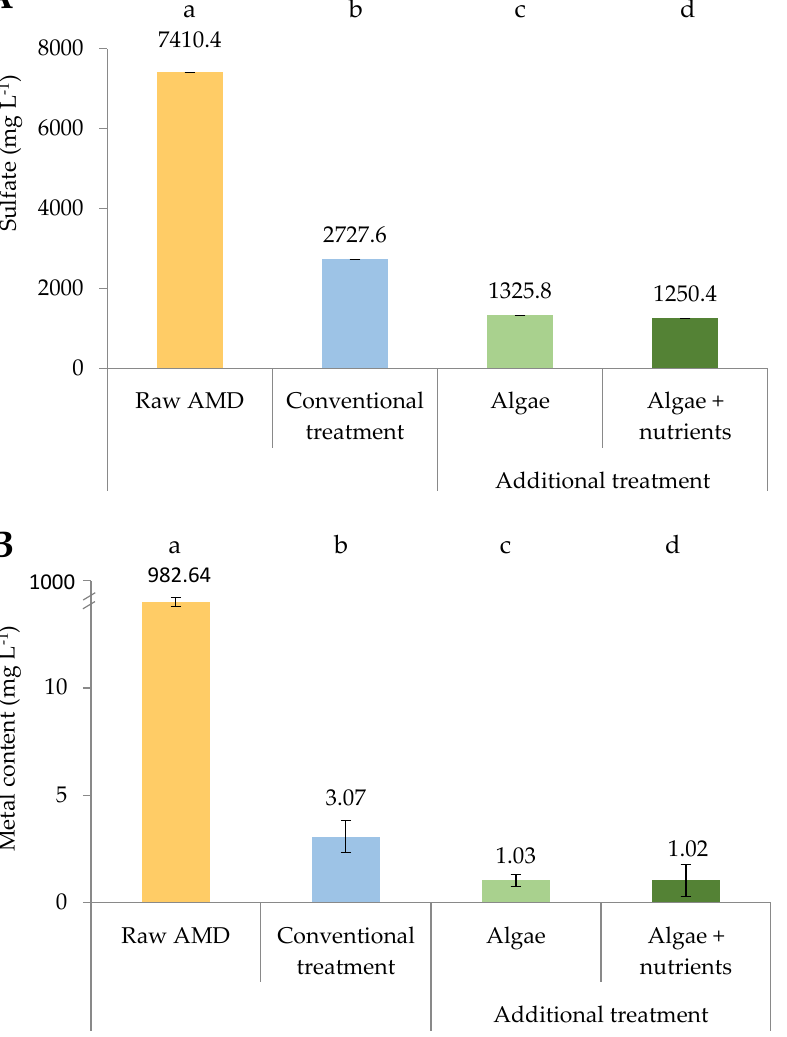
Figure 3. Comparison between raw AMD, conventional and additional treatments in terms of sulfate ( A ) and metal content ( B ). Means that differ significantly (Tukey’s test, p < 0.05) are indicated by different lowercase letters.